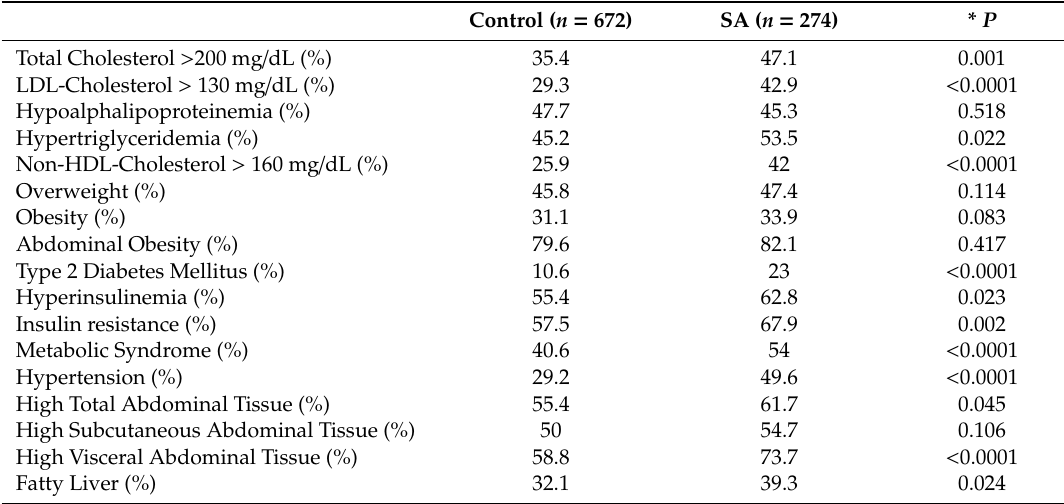
Table 2. Cardiovascular factors prevalence in the study population.